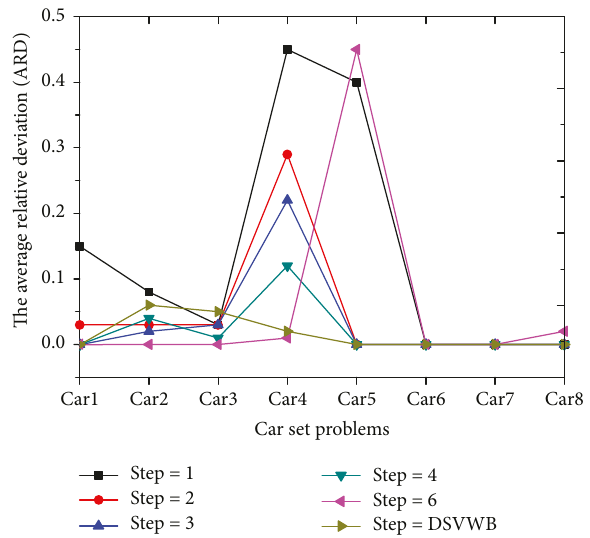
Figure 1: The ARD line chart for Car set problems with di ff erent